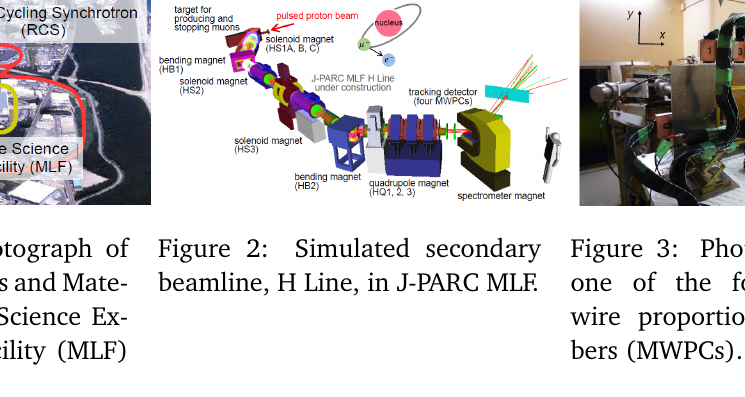
Figure 1: Photograph of the accelerators and Mate- rials and Life Science Ex- perimental Facility (MLF) at J-PARC.